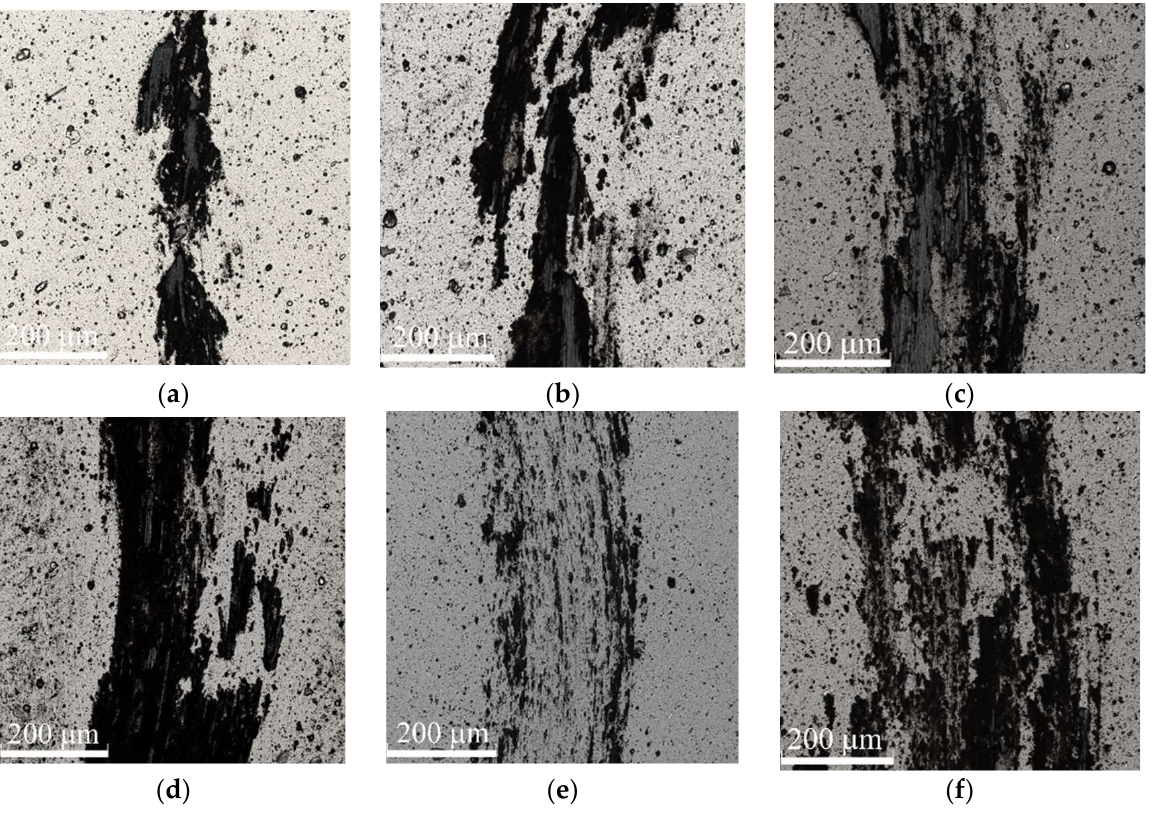
Figure 5. Optical micrographs of the worn surfaces on the ZrN ( a ), CrN ( b ), ZrCrN(0.5) ( c ), ZrCrN(3.5) ( d ), ZrCrN(5) ( e ) and ZrCrN(8) ( f ) samples after sliding at 1Н.